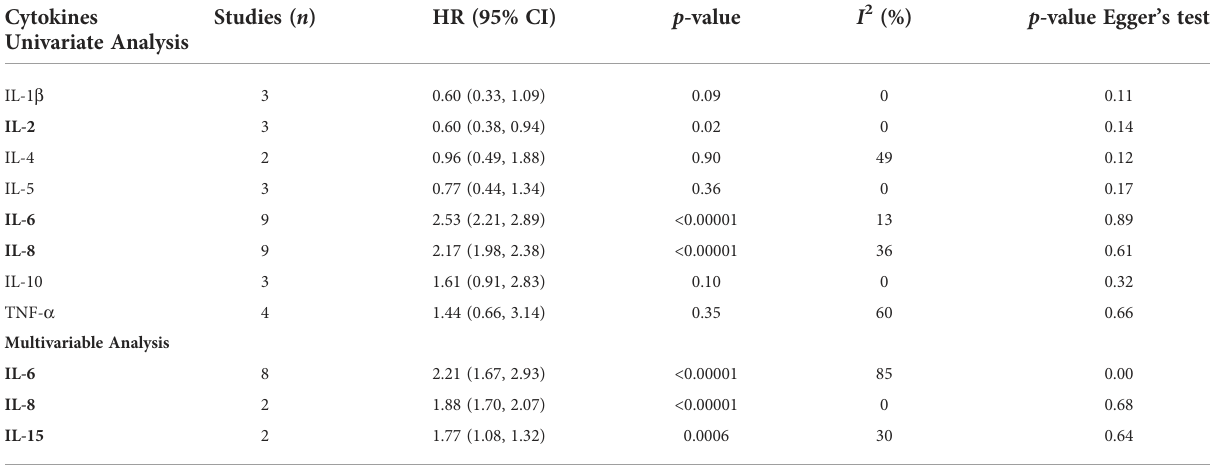
TABLE 2 Meta-analysis investigated the association between cytokines and OS.